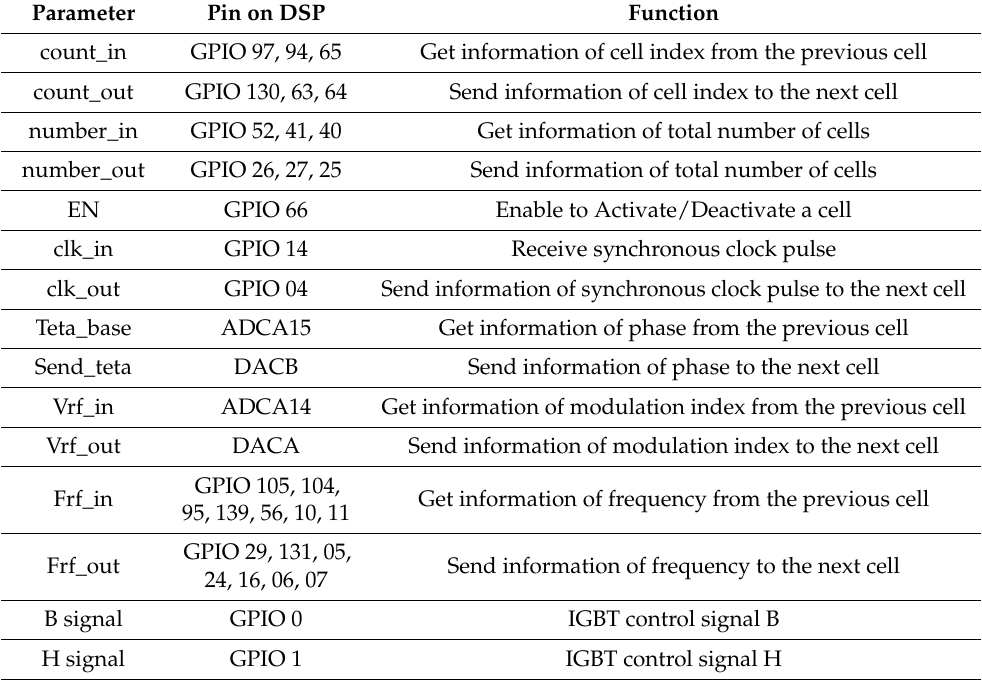
Figure 38. System experimental diagram using DSA-LSC method. Table 10. Function of control pins of DSP for algorithm DSA-LSC.